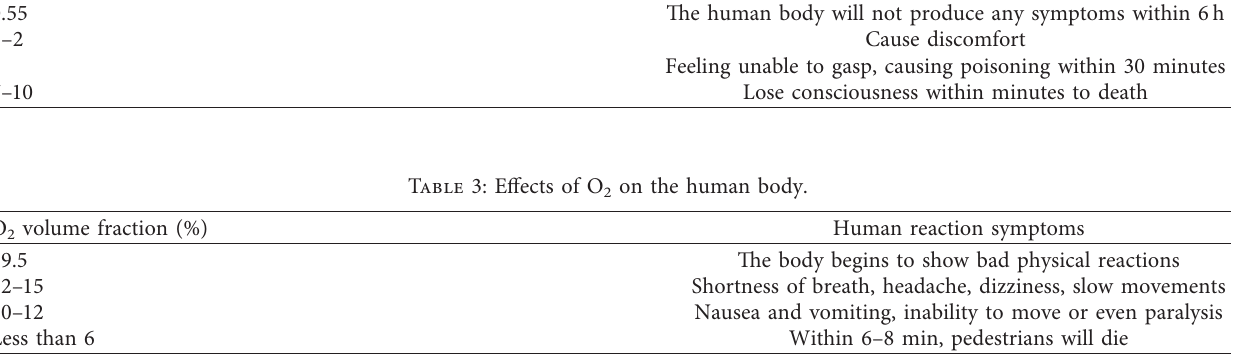
Table 2: Effects of CO